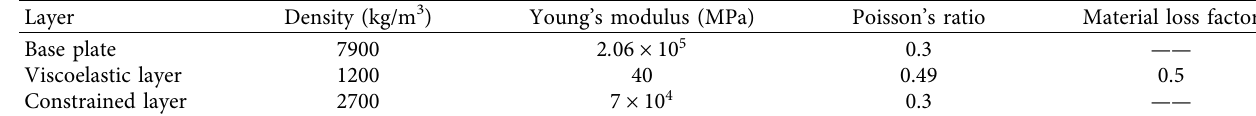
Figure 2: Flowchart for the optimization procedure. Table 3: Physical parameters of the CLD plates.